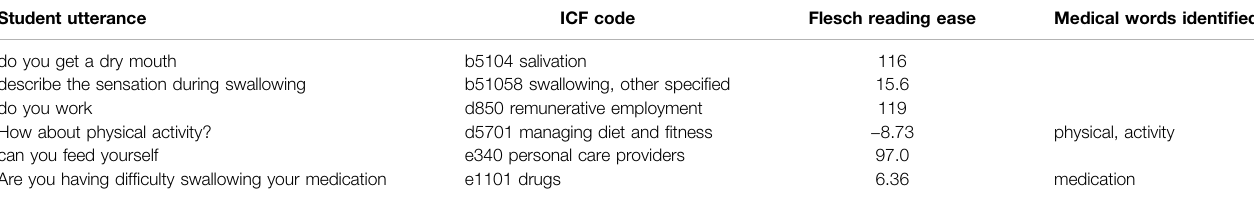
TABLE 2 | Examples of ICF codes, Flesch Reading Ease scores, and medical words identi fi ed for measures in the Message Production Trends study. Student